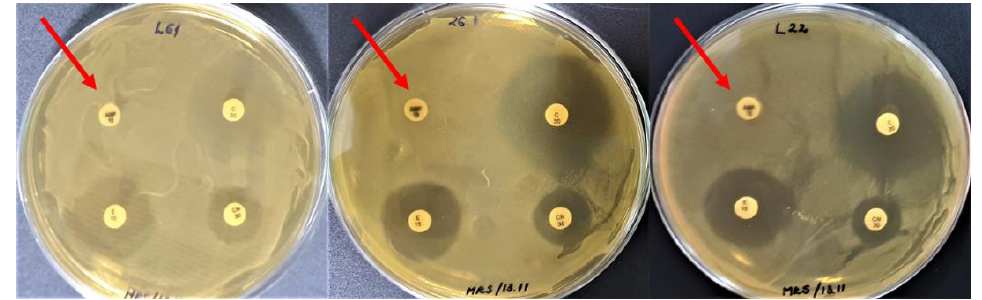
Figure 1. LAB strains revealing ampicillin resistance (arrows).